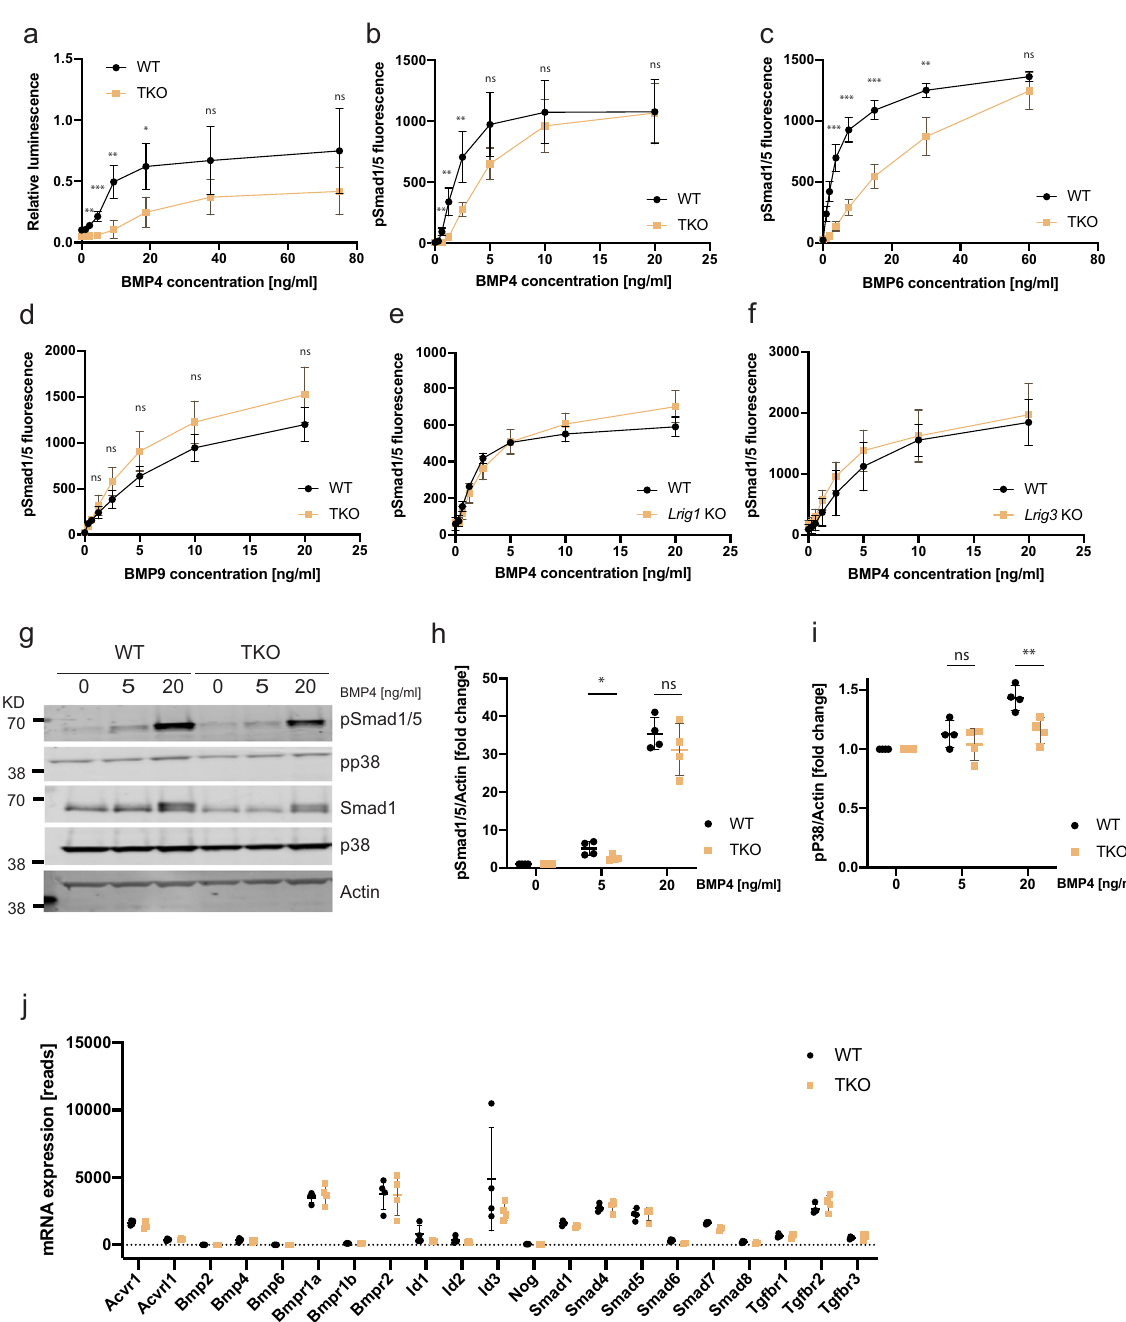
Fig. 2 Lrig -null MEFs show impaired BMP signaling without any apparent changes in the expression of receptors or signaling mediators. a Wild-type (WT) and Lrig -null (TKO) MEFs expressing the BMP reporter plasmid pGL3-BRE-luciferase were treated with the indicated concentrations of BMP4 for three hours. Thereafter, the cells were lysed, and the luciferase activity was analyzed and normalized to the control. b – d Wild-type and Lrig -null MEFs were stimulated with various concentrations of BMP4 ( b ), BMP6 ( c ), or BMP9 ( d ) for one hour followed by immunocyto fl uorescence analysis of nuclear phospho-Smad1/5 (pSmad1/5). e , f Wild-type and Lrig1 -null MEFs ( e ) or wild-type and Lrig3 -null MEFs ( f ) were stimulated with various concentrations of BMP4 for one hour followed by nuclear pSmad1/5 analysis. g – i Western blot analyses of canonical BMP4 signaling through pSmad1/5 and noncanonical BMP signaling through phosphorylated p38 (pp38). Wild-type and Lrig -null MEFs were stimulated with the indicated concentrations of BMP4 for one hour followed by cell lysis and Western blot analysis. Uncropped blots are shown in Supplementary Fig. 3. g Representative Western blots showing pSmad1/5, pp38, total Smad1, total p38, and the loading control actin. h Quanti fi cation of the pSmad1/5/actin ratios. i Quanti fi cation of the pp38/actin ratios. j Gene expression levels were analyzed in wild-type (WT) and Lrig -null (TKO) MEFs via RNA sequencing (RNAseq). The apparent number of RNAseq reads for respective gene is indicated. All the values in a – f , h and i represent the means of four biological replicates that were analyzed by three experimental repeats each. j The values represent the means of four biological replicates that were analyzed once. Error bars represent the standard deviations of means from four biological replicates. ns P > 0.05, * P < 0.05, ** P < 0.01, *** P < 0.001 (Student ’ s t